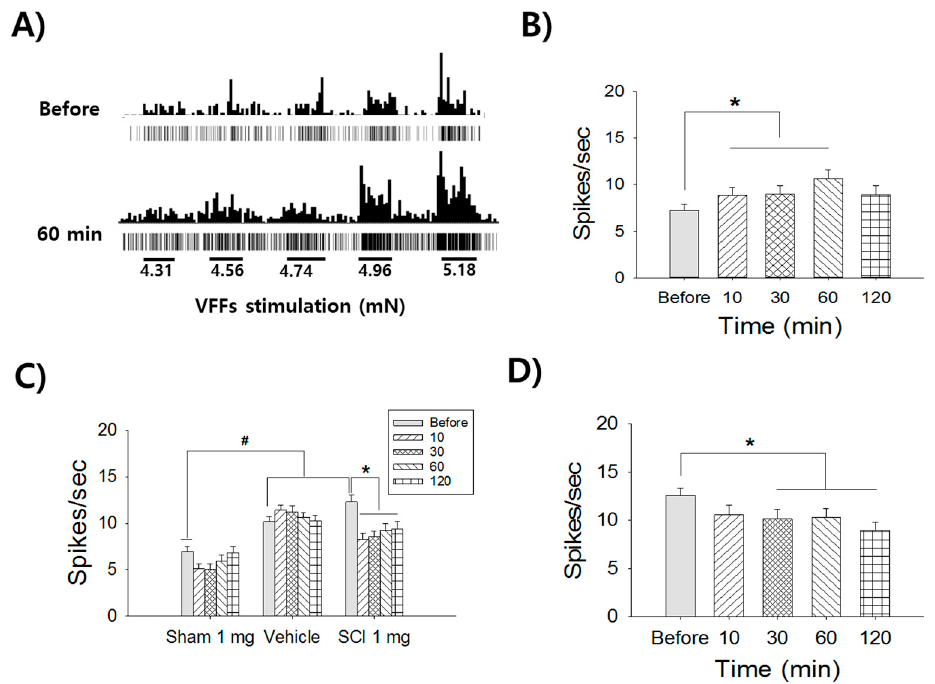
Figure 1. The contribution of superoxide on thoracic WDR neuronal firing rates. ( A ) The single WDR neuronal firing rates show increasing patterns to 5 different graded-intensity stimuli of VFFs prior to t-BOOH treatment (Before) and after (60 min) in naïve rats. Each VFF stimulation was applied for 10 s at the dorsal body trunk. ( B ) Cumulated firing rates show significant increases up to 60 min in the naïve group. ( C ) Prior to drug application, SCI-induced neuronal firing rates (Before) show significant increases in both the vehicle and SCI 1mg groups compared to the sham control ( # p < 0.05). Application of Tempol 1 mg significantly attenuates WDR neuronal firing rates from 10 min to 120 min, whereas the vehicle shows no changes in SCI rats (* p < 0.05). ( D ) Application of PBN 3 mg significantly attenuates WDR neuronal firing rates from 30 min to 120 min (* p < 0.05).